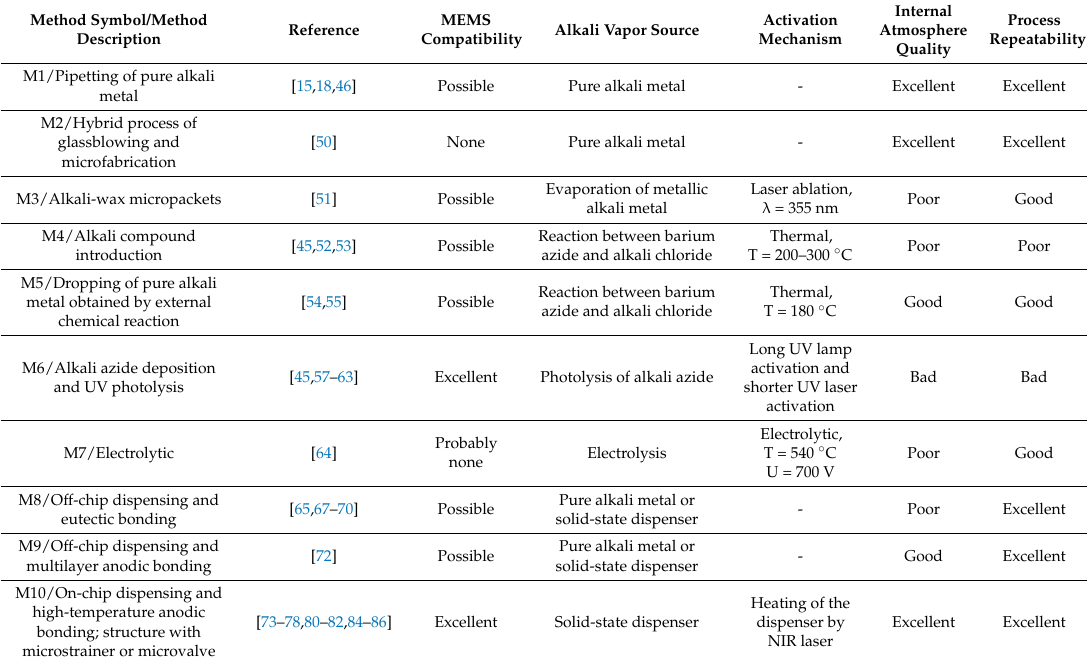
Table 1. Collation of introduction methods.